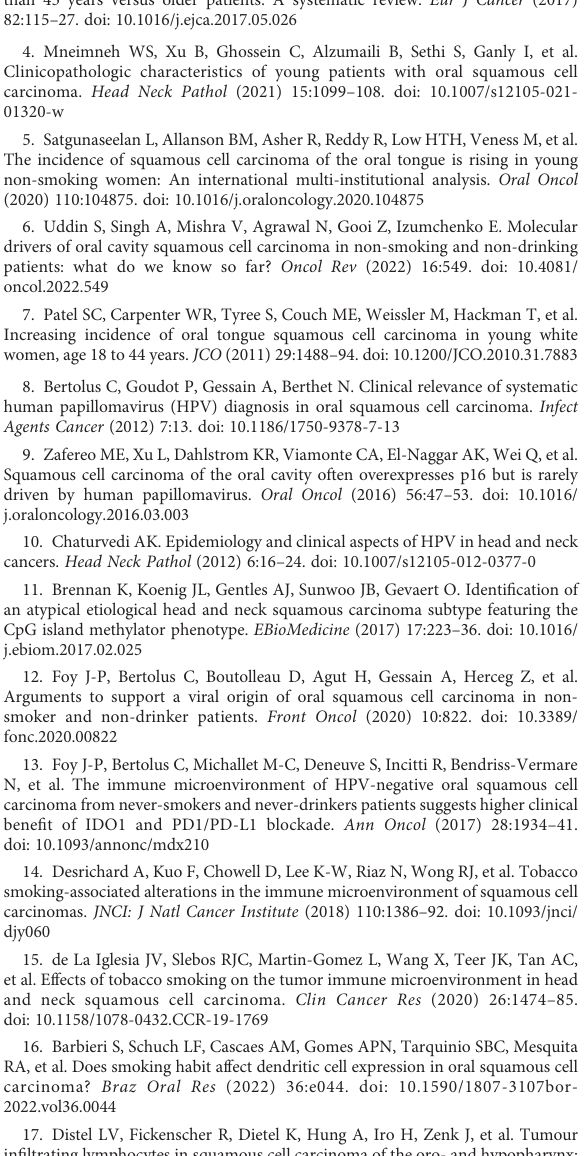
(monocytes-macrophages (Mo-M f ), CD19 + CD3 - (B cells), CD3 + CD4 + (CD4